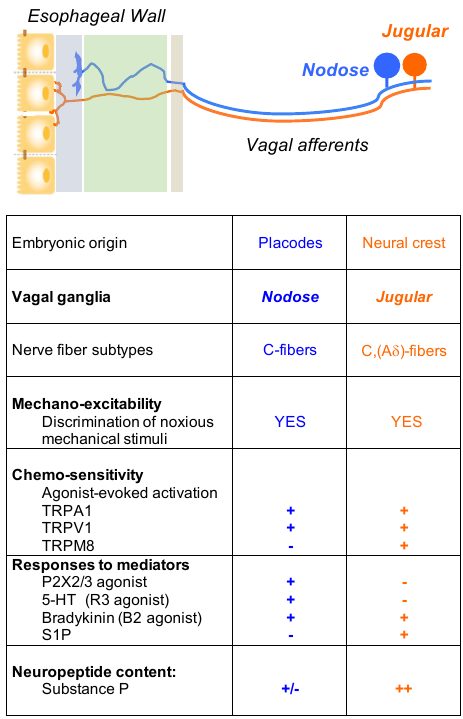
Figure-2: Nociceptive Vagal Afferent Subtypes in the Esophagus Figure 2. Nociceptive vagal afferent subtypes in the